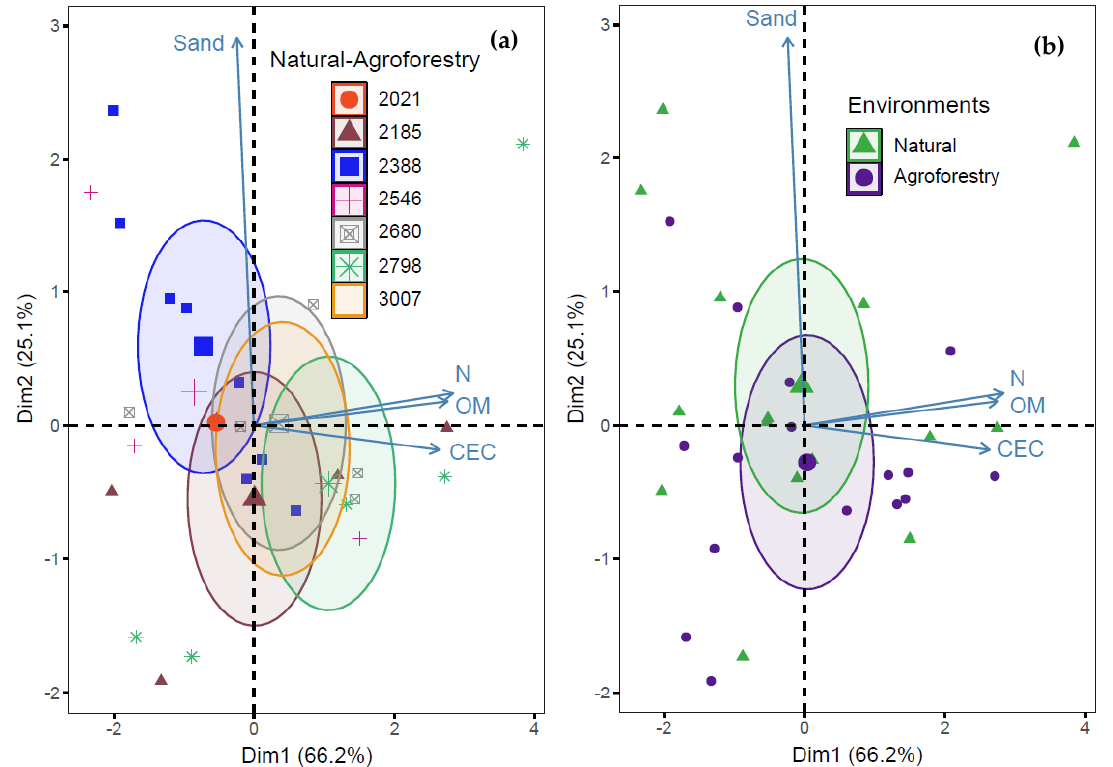
Figure 2. Principal component analysis (PCA) of organic matter (OM), cation exchange capacity (CEC), sand, and nitrogen (N) in the soil. ( a ) All altitude classes within the natural and agroforestry environments. ( b ) All plots in the natural and agroforestry environments, Cajamarca region, Andes Mountain range, Peru.